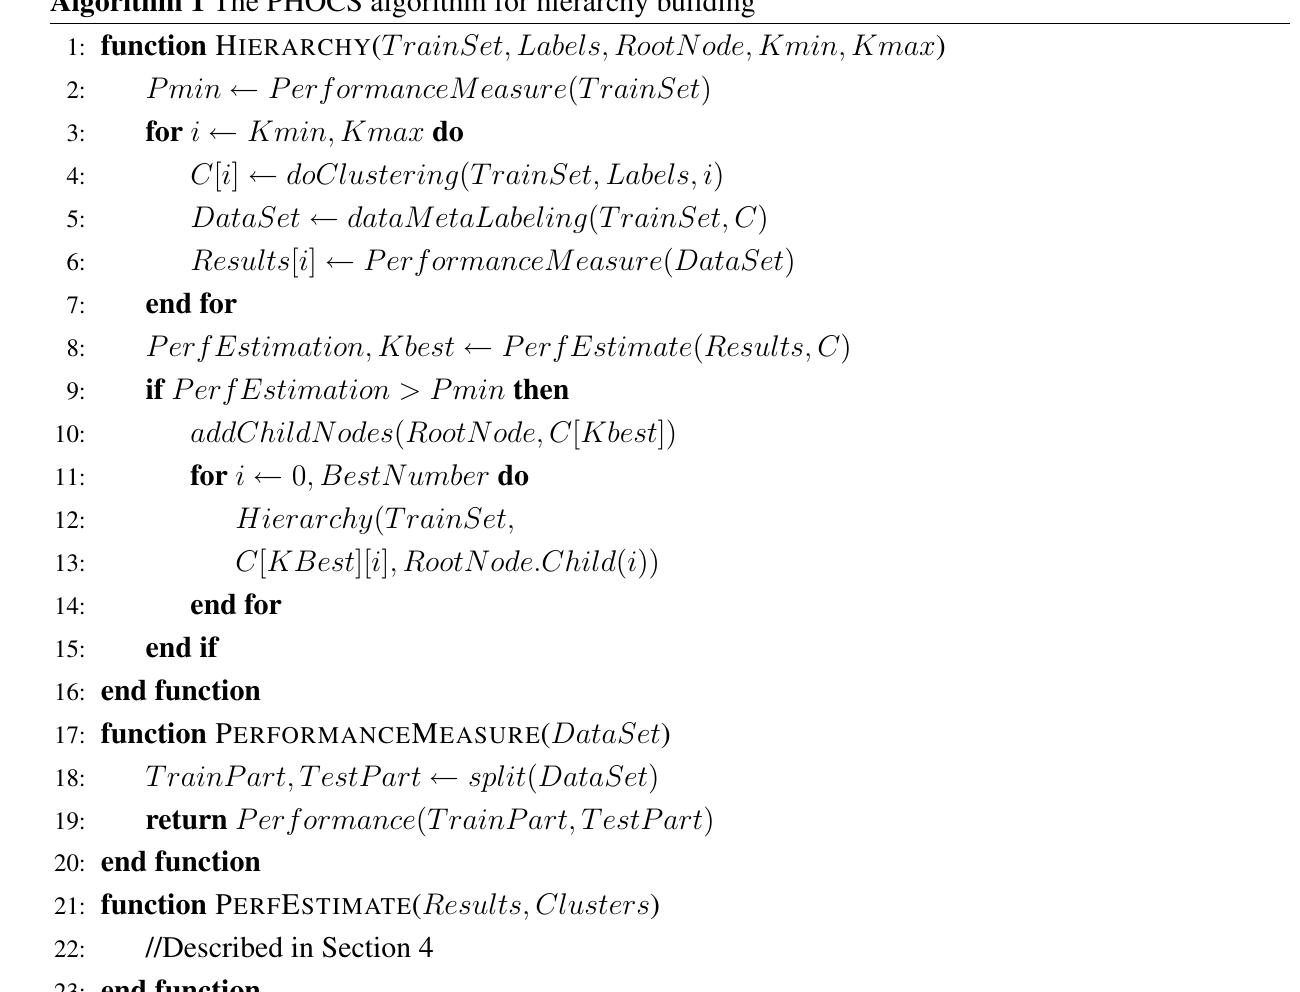
Algorithm 1 The PHOCS algorithm for hierarchy